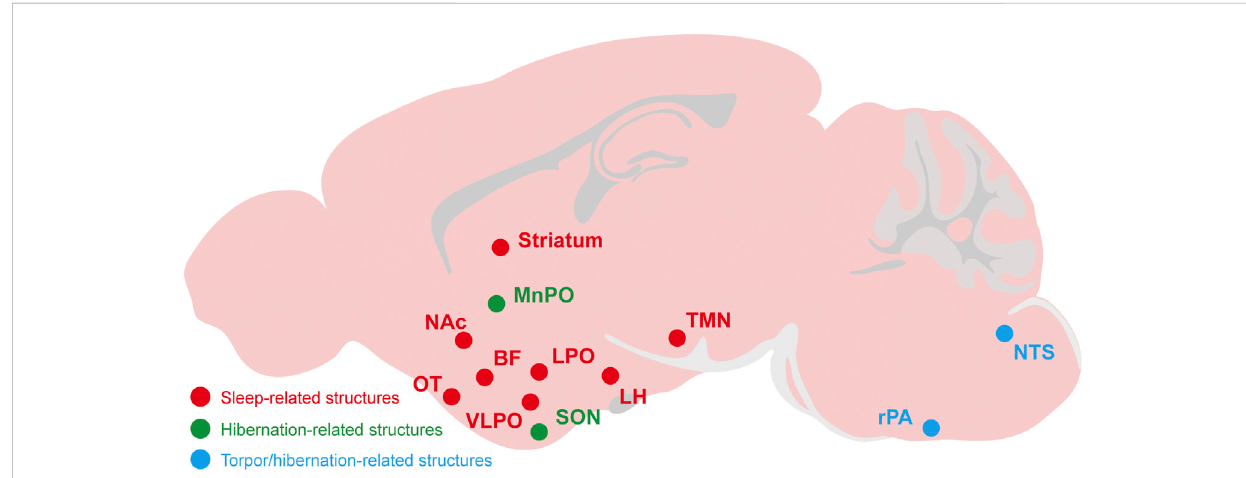
The relevant brain regions about adenosine and P1 receptors mediate sleep, torpor, and hibernation. The CNS adenosine and P1 receptors are important for the regulation of sleep-wake, torpor and hibernation. The roles and mechanisms of several brain regions and nuclei have been gradually revealed,suchastheA 2A Rs-expressingneuronsintheNAc,striatum,OTandotherstructureshaveasigni fi canteffectonsleep-wakeregulation.TheNTS and rPA may be the key brain regions of adenosine and P1 receptors mediating torpor and hibernation. NAc, nucleus accumbens; OT, olfactory tubercle; LH, lateral hypothalamus; BF, basal forebrainvlpo; VLPO, ventrolateral preoptic nucleus; LPO, lateral preoptic area; MnPO, median preoptic area; SON, supraoptic nucleus; TMN, tuberomammillary nucleus; rPA, raphe pallidus; NTS, nucleus tractus